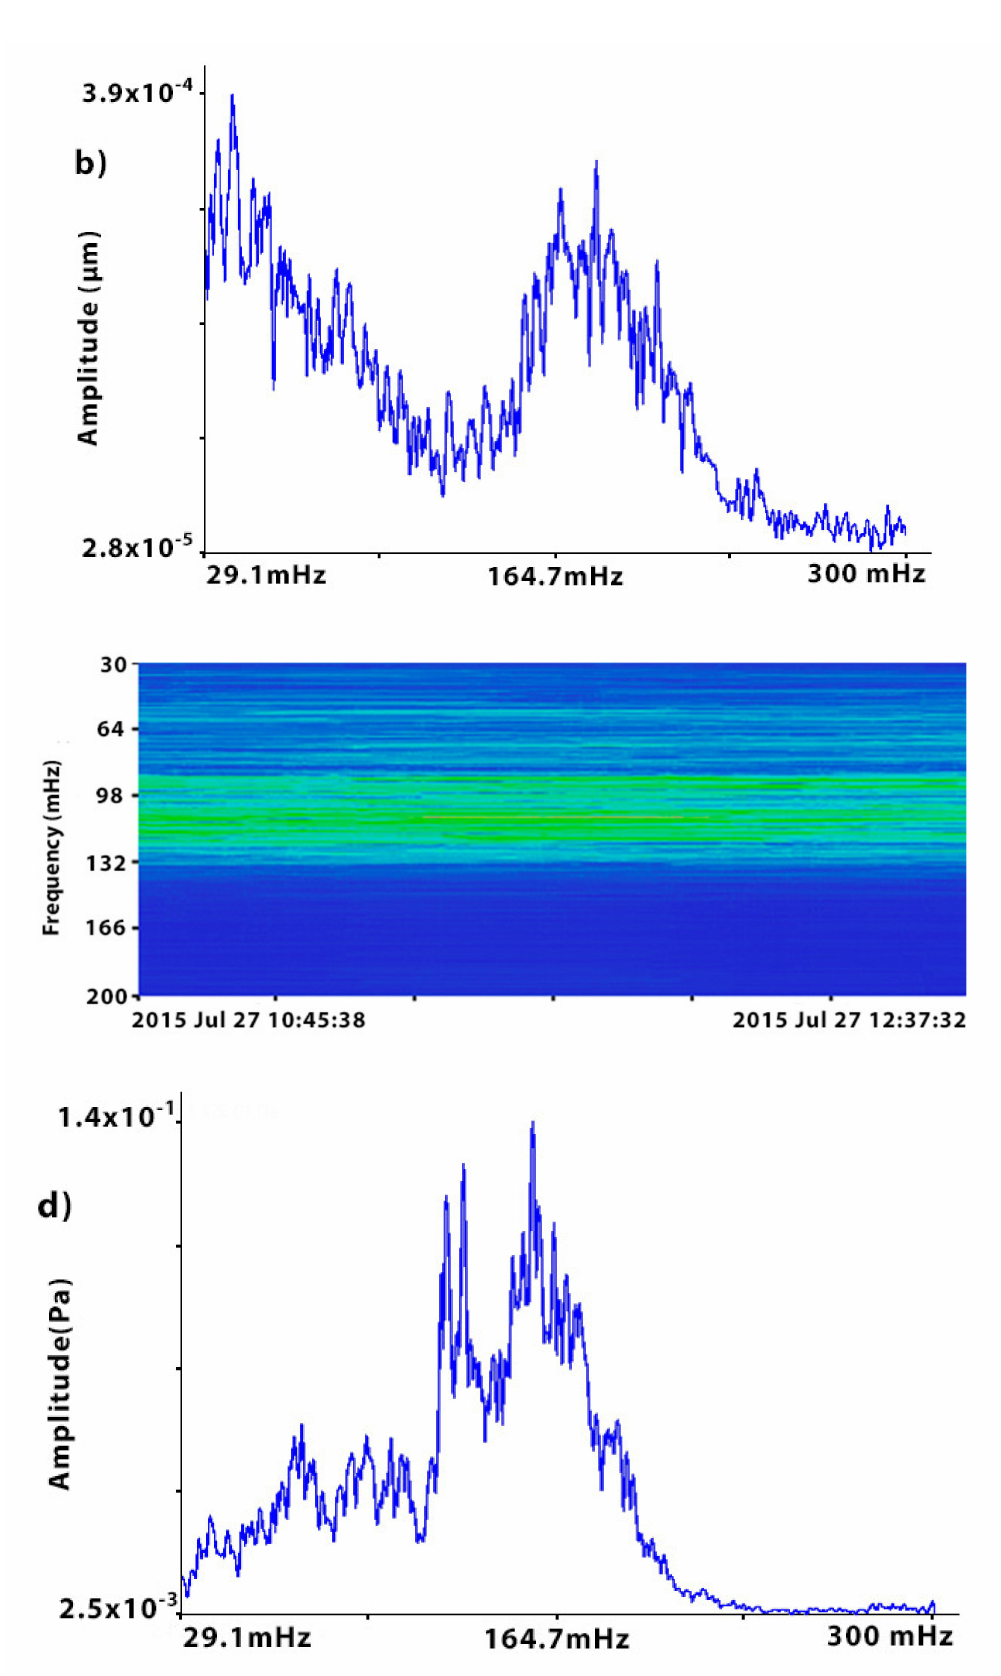
Figure 9. Dynamic spectrograms and spectra of synchronous records of laser strainmeter and laser meter of hydrosphere pressure variations. ( a , b )—Laser strainmeter, ( c , d )—laser meter of hydrosphere pressure variations